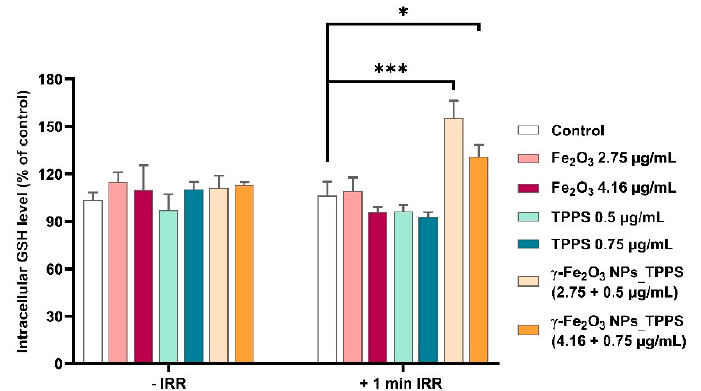
Figure 14. Variation of reduced glutathione (GSH) content in Mel-Juso cells incubated for 24 h with 2 different doses of γ -Fe 2 O 3 NPs, TPPS and their complex and submitted or not to 1 min led irradiation ( λ ~ 405 nm, 1 mW/cm 2 ). Data ( n = 3) were expressed as percentages related to control ± standard deviation (SD). The results were considered statistically significant when * p < 0.05; *** p < 0.001 (sample vs. control).